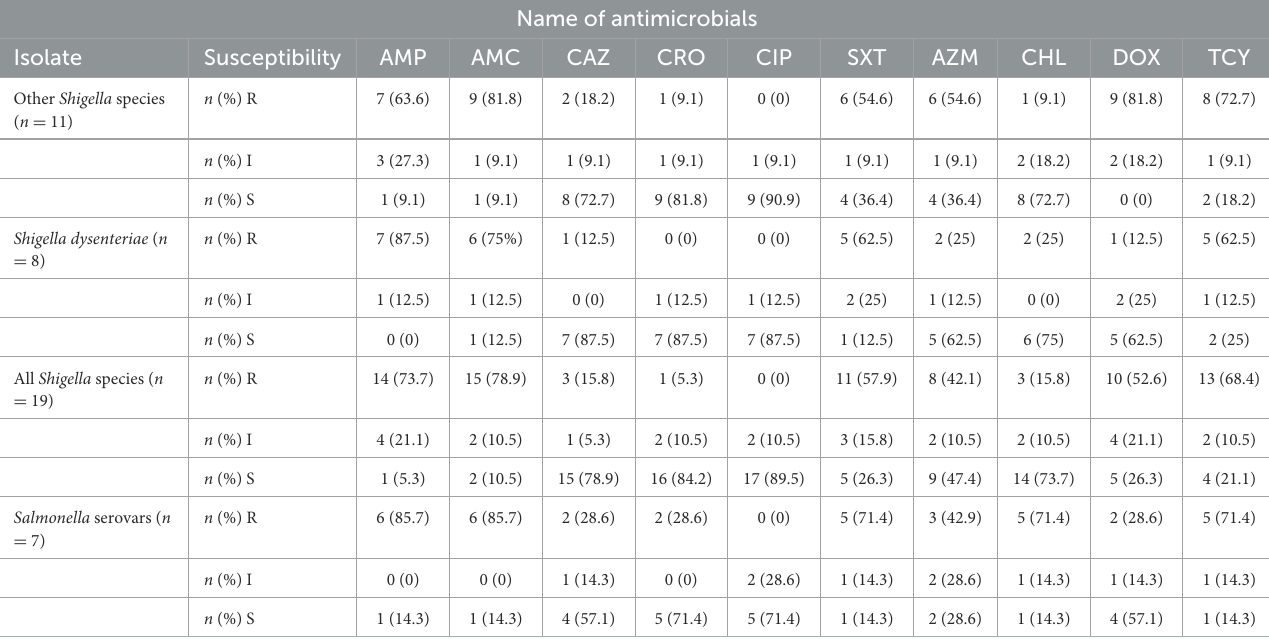
TABLE 4 Antimicrobial resistance pattern of Salmonella serovars , S. dysenteriae, other Shigella species, and all Shigella species isolated from under-five diarrheic children in public health facilities in Debre Markos town, Northwest Ethiopia, 2022. Name of